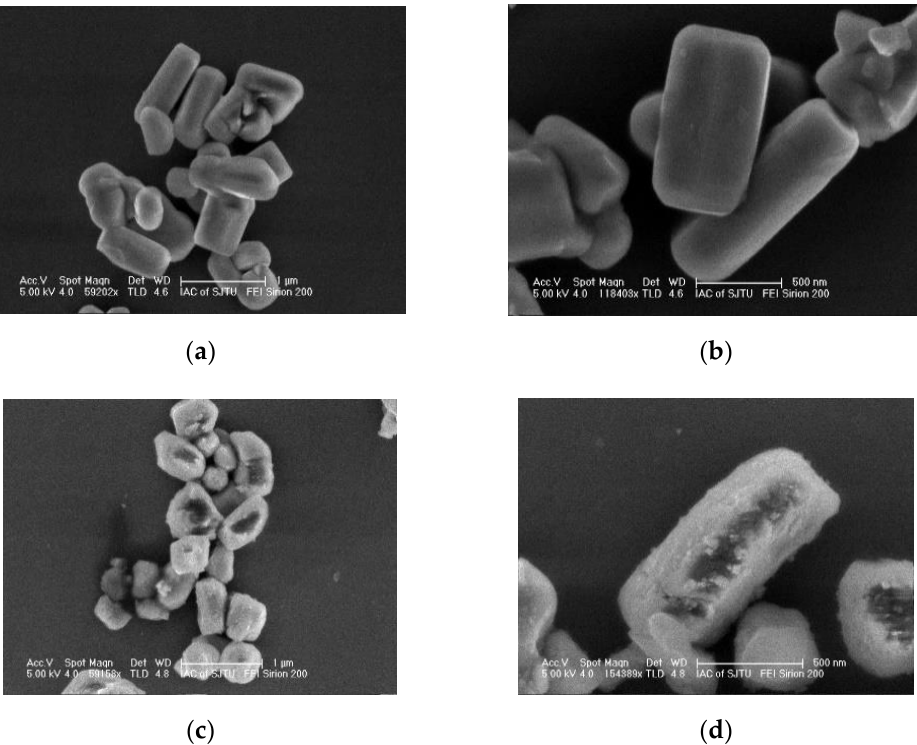
Figure 2. FESEM results for the ( a , b ) bare and ( c , d ) MnO 2 -coated LTMO particles.